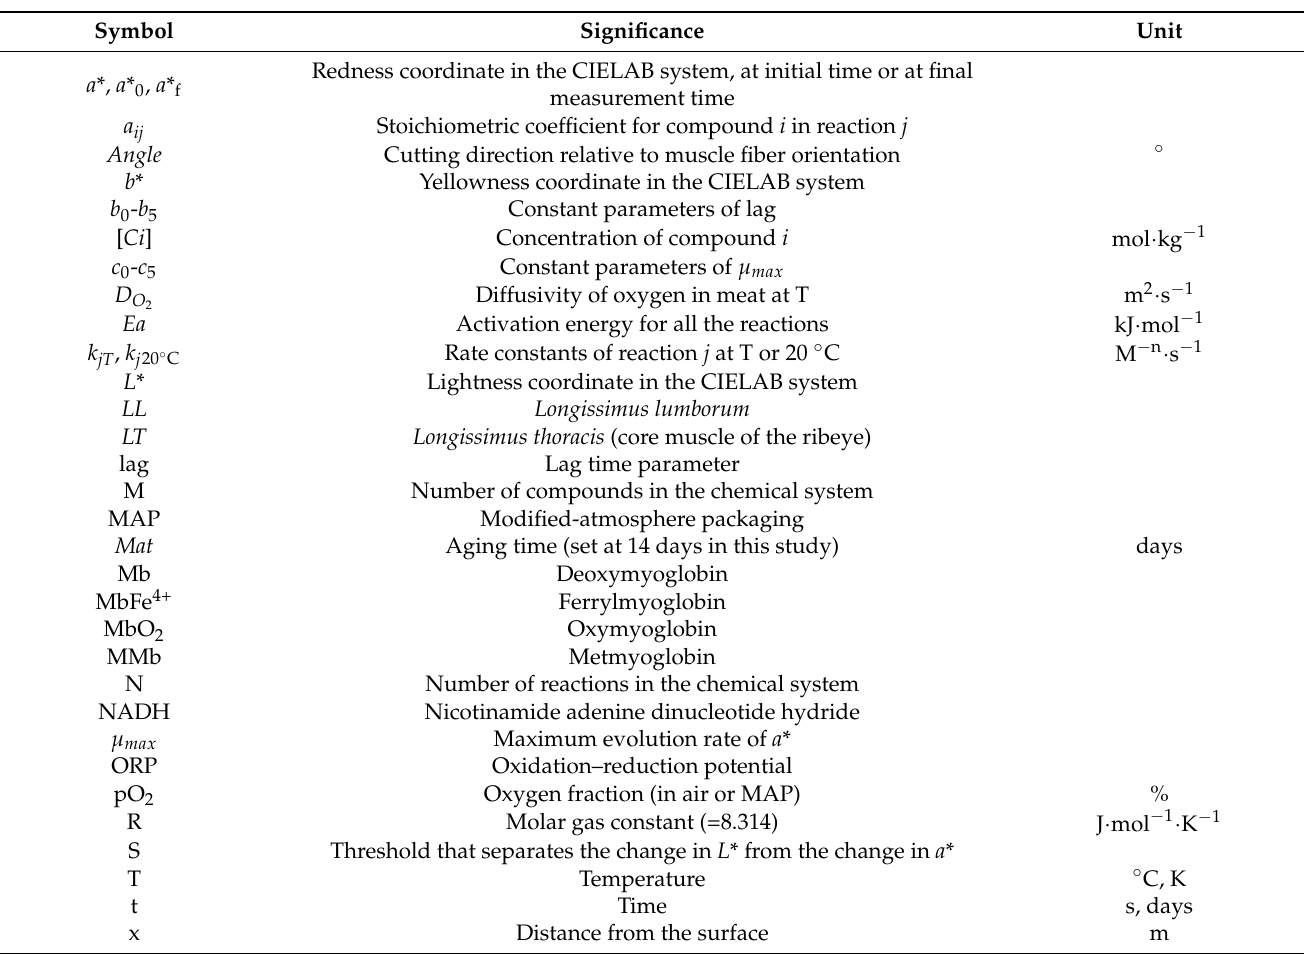
Table A1. List of